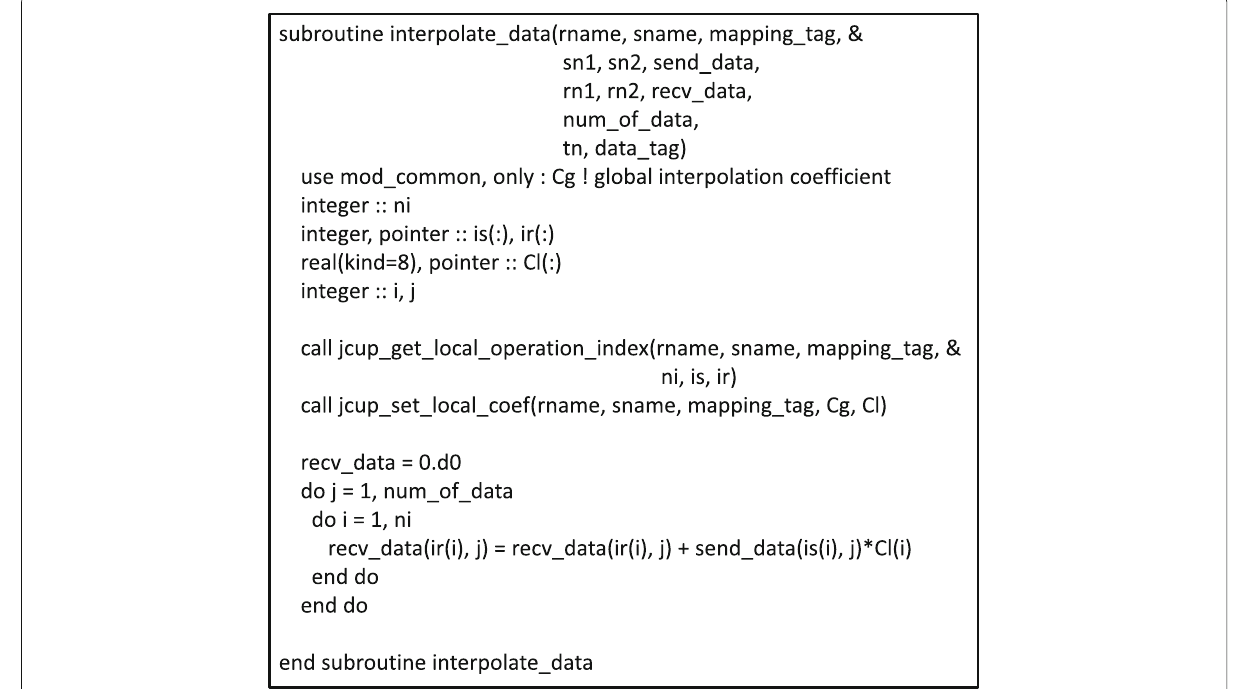
Fig. 5 A simple implementation example of the subroutine